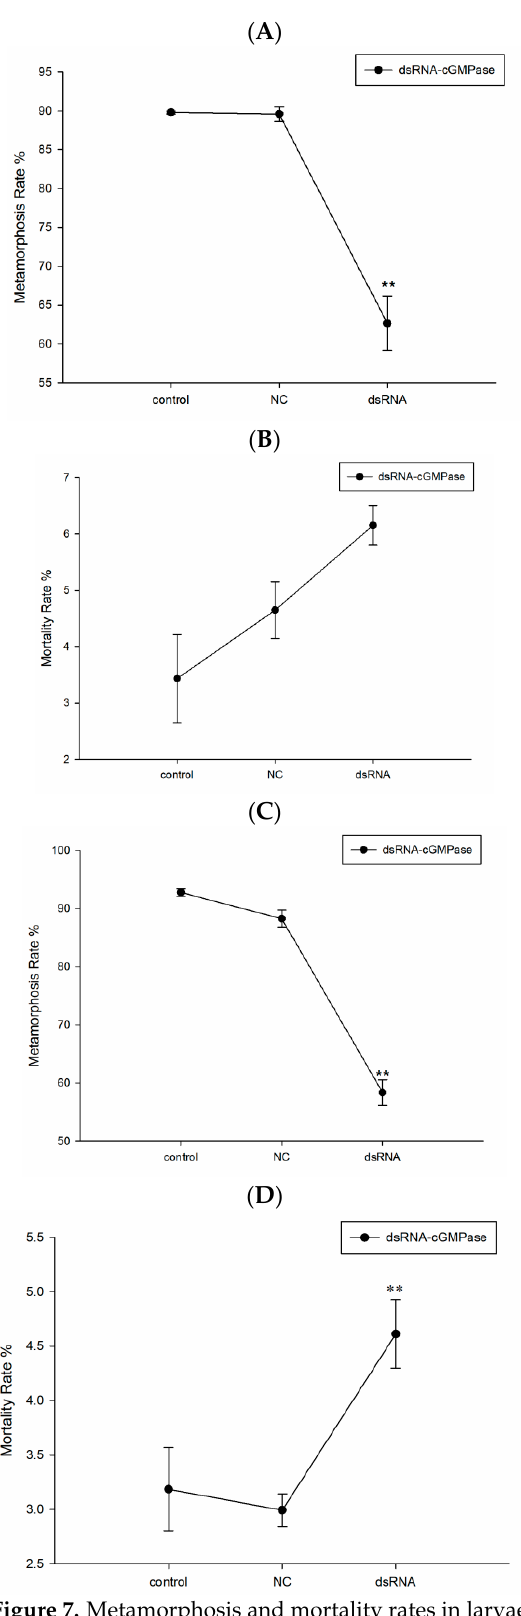
Figure 7. Metamorphosis and mortality rates in larvae during dsRNA interference against cGMPase ( A – D ) at TPH-DVE and UMBO-CRE stages: ( A , B ) metamorphosis and mortality rates in larvae at the TPH-DVE stage, respectively; ( C , D ) metamorphosis and mortality rates in larvae at the UMBO-CRE stage, respectively. Double asterisks mean a highly significant difference (** p <